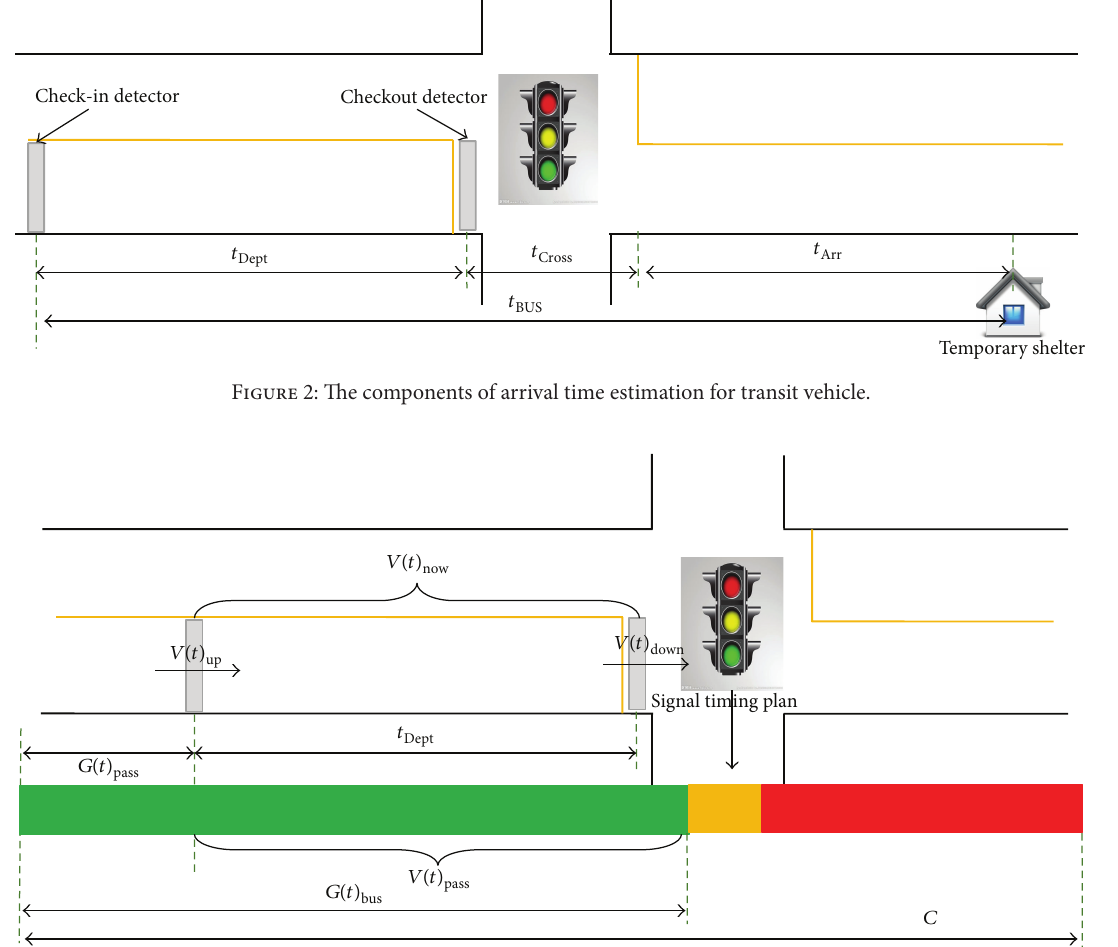
Figure 3: The signal status when transit vehicle arrives at the check-in